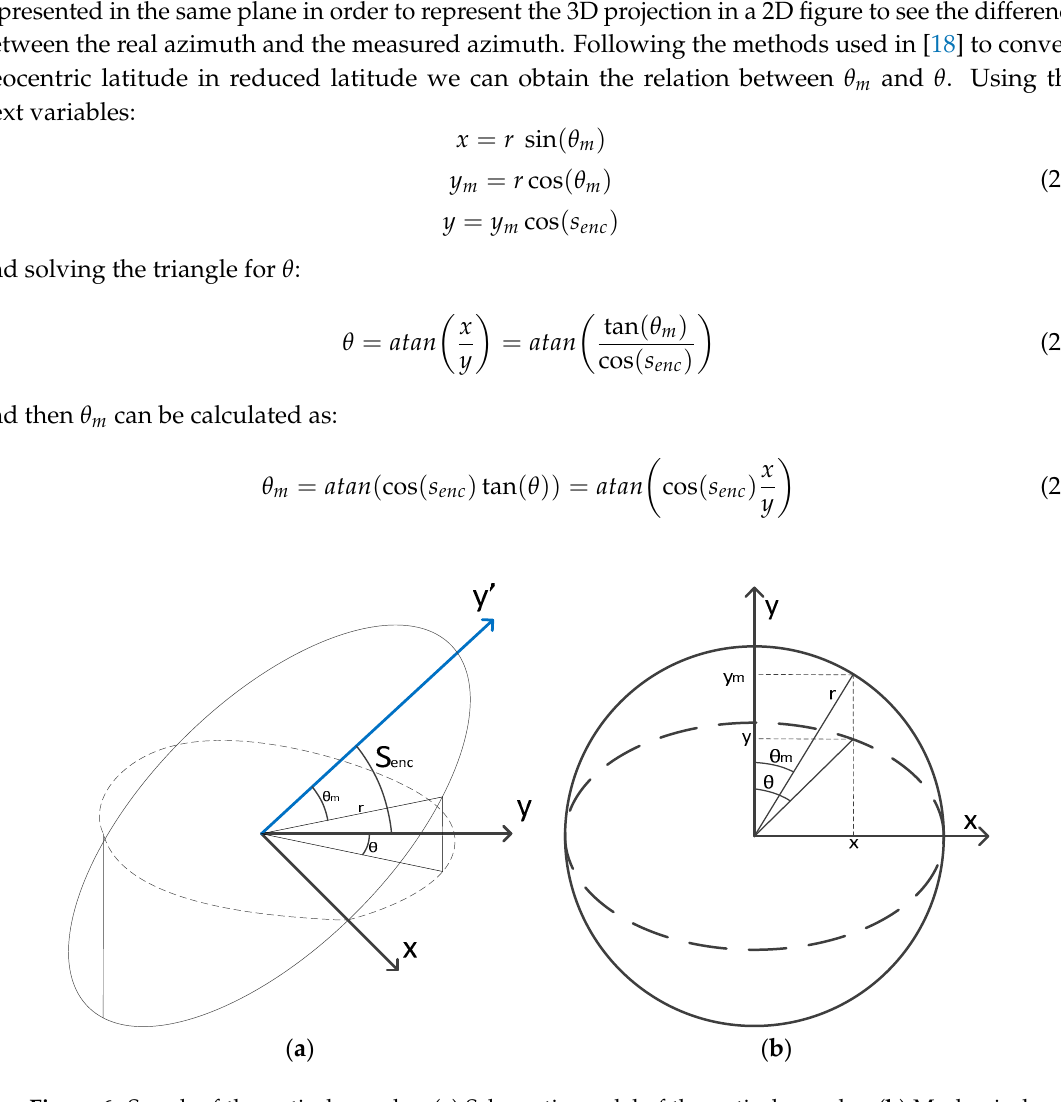
Figure 6. Swash of the optical encoder. ( a ) Schematic model of the optical encoder; ( b ) Mechanical encoder circumference and its projection on the horizontal plane.